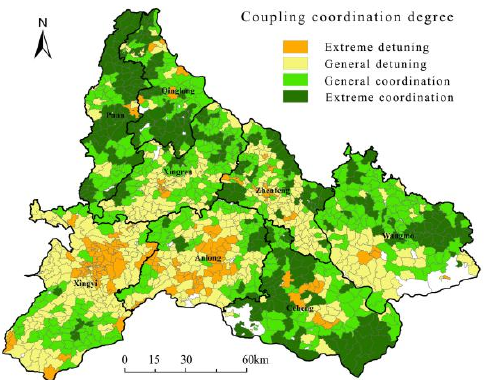
Figure 8. Coupling coordination degree of density of relocated population, and change in RSEI.